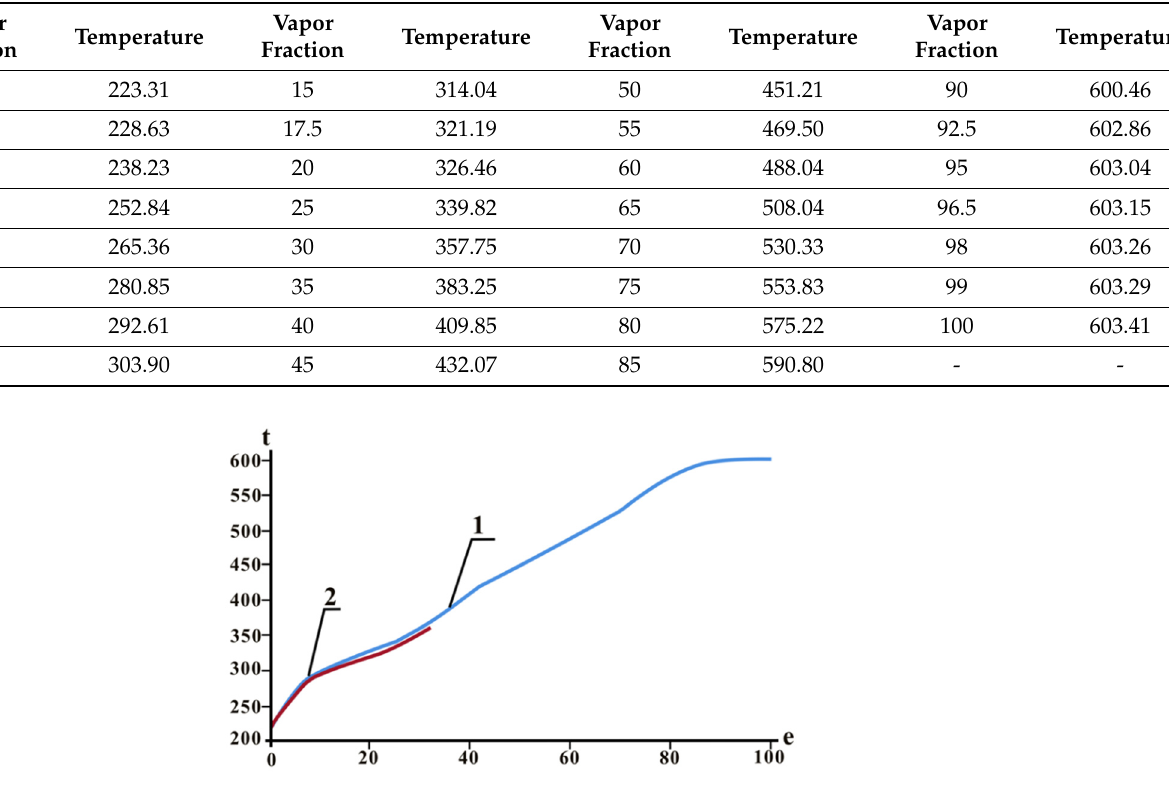
Figure 9. Introduced in basis 1 and experimental 2 curves of distillation of fuel oil. The calculated parameters of the mixture are presented in Table 12. Table 12. Calculated parameters of the initial